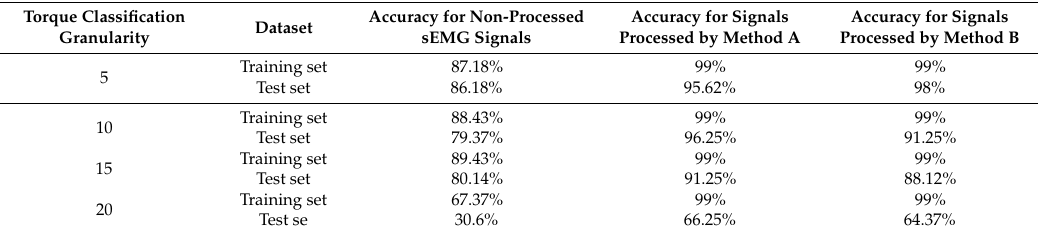
Table 1. Accuracies of di ff erent torque classification granularities and preprocessing methods.